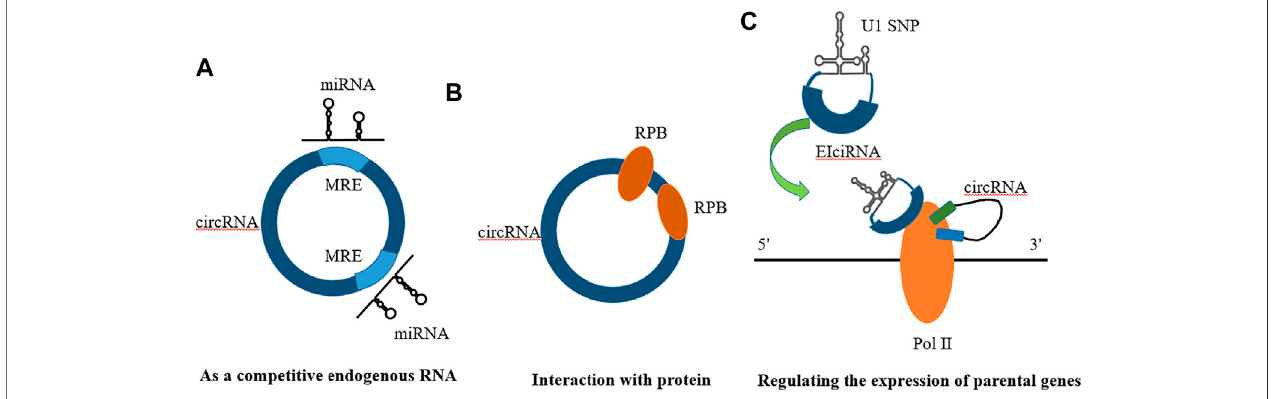
FIGURE 4 | Mechanisms of circRNA action. (A) As a compentitive endogenous RNA (B) Interaction with protein (C) Regulating the expression of parental